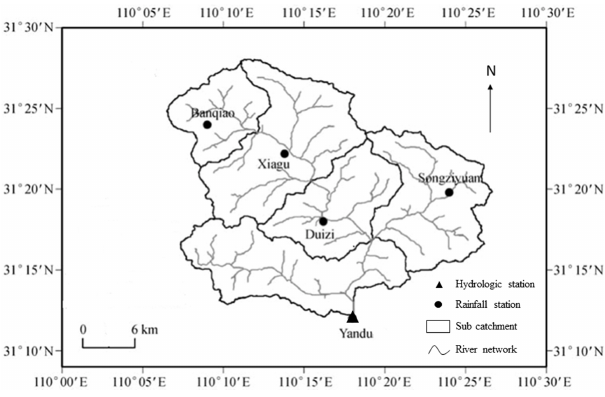
Figure 1. River networks and observational station distribution.